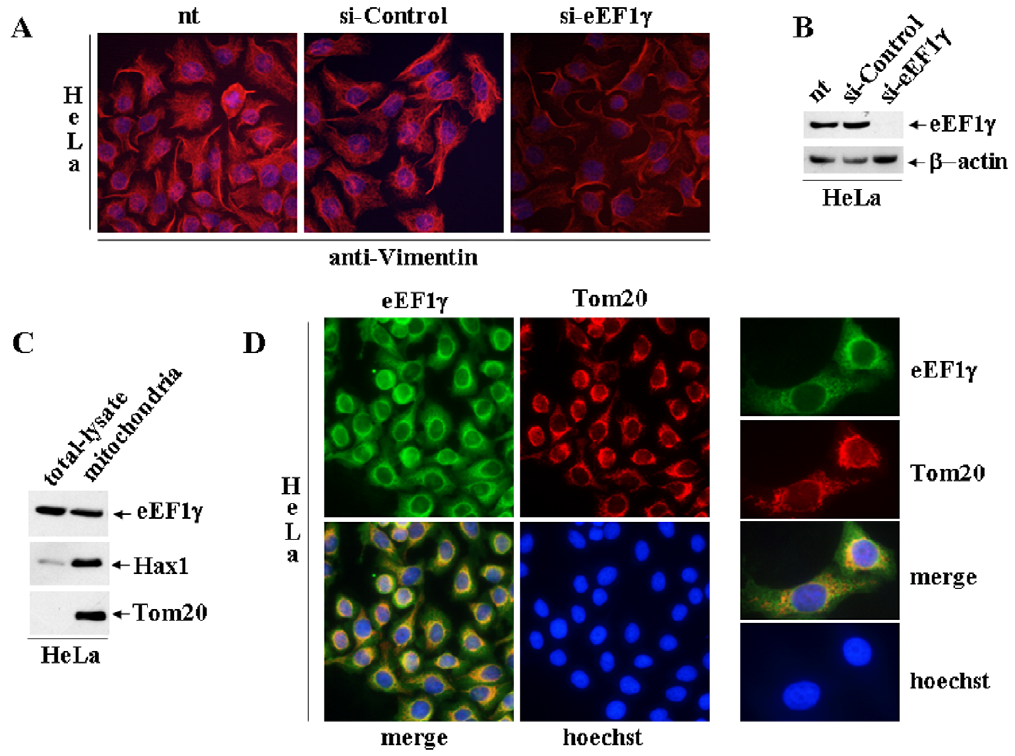
Figure 4. eEF1 c partially co-localizes with mitochondria and its depletion influences Vimentin protein localisation. A : Indirect immunofluorescence of Vimentin, obtained with the monoclonal antibody anti-Vimentin, in HeLa cells: untreated, treated with siRNA-Control and eEF1 c -depleted by specific siRNA. B : Western blot analysis of HeLa cells (from panel A): untreated and treated with either siRNA-Control or with eEF1 c specific siRNA. C : Western blot analysis of HeLa cell total lysate and the enriched mitochondrial fraction. The quality of mitochondrial enriched fraction was monitored using the anti-Hax1 monoclonal antibody and the anti-Tom20 rabbit polyclonal antibody. D : Dual-label indirect immunofluorescence performed in HeLa cells with the anti-Tom20 rabbit polyclonal antibody and the anti-eEF1 c monoclonal antibody to visualise the immunolocalisation of endogenous eEF1 c (green) and Tom20 (red). Extensive co-localization (yellow) between eEF1 c and Tom20 is visualised by the merged-colour image. On the right side, the same immunofluorescences are presented at a higher magnification (100 6 ).